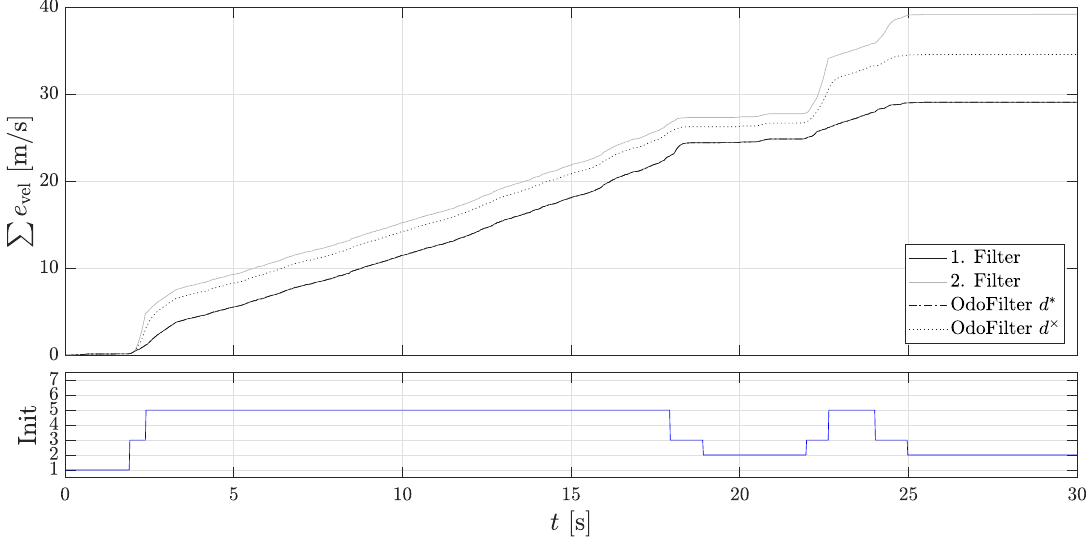
Figure 8. Accumulated velocity errors of the Dual-Localization filter during parking. ( Top ): The accumulated velocity errors of the 1st and the 2nd localization filter, of the localization filter using the fused estimated velocity of the new methods, and of the velocity of the localization filter using the rolling direction of the DWPC signal; ( Bottom ): Initialization